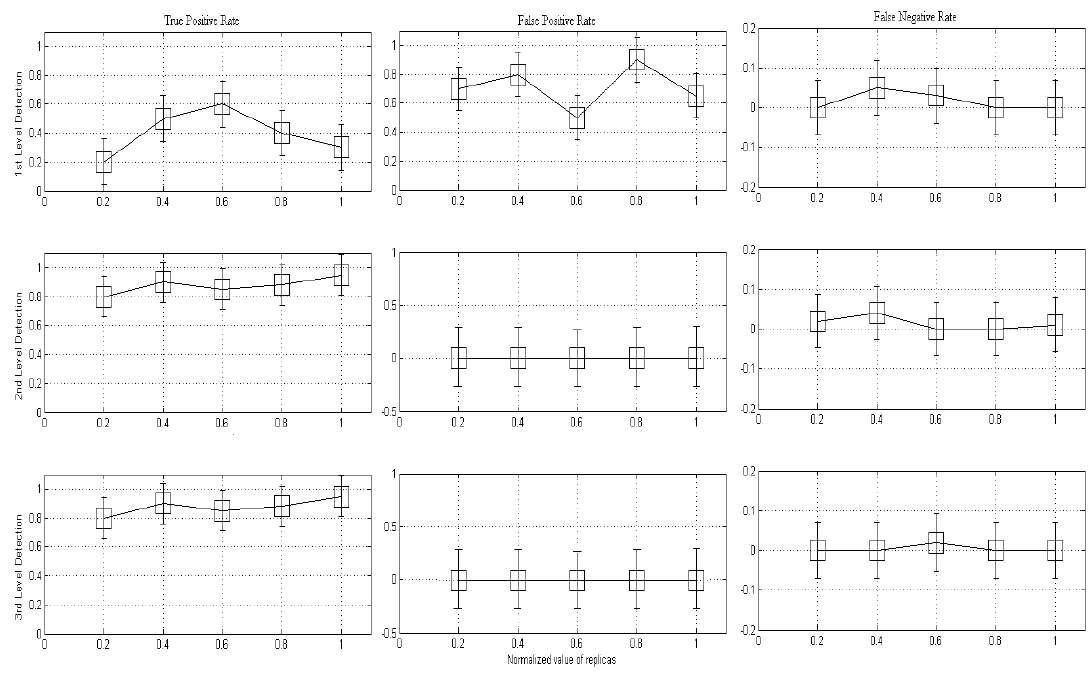
Figure 6. Different stages of clone detection in MWSN.